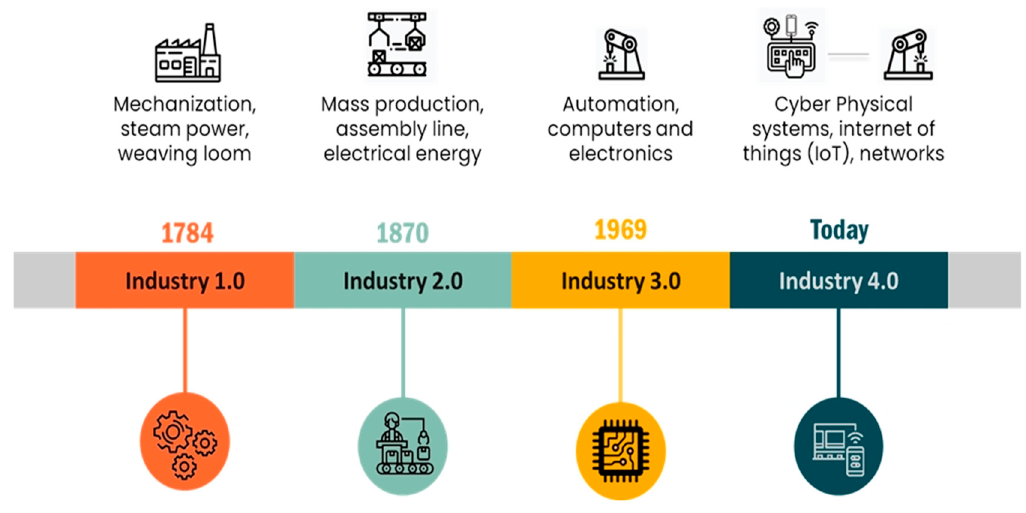
Figure 1. Industry 4.0—Fourth Industrial Revolution (self-elaboration).